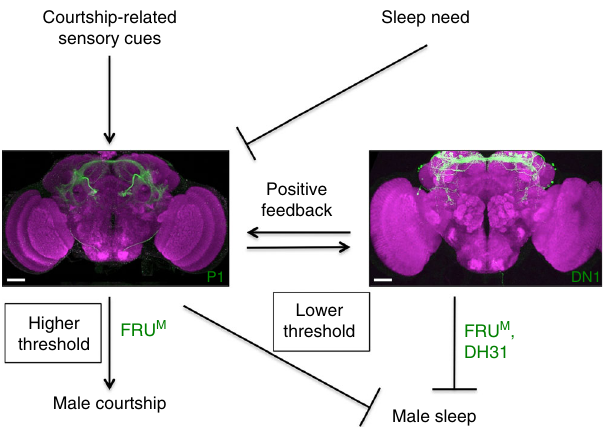
Fig. 10 Sex-speci fi c interaction between courtship and sleep. The male-speci fi c P1 neurons integrate external courtship-related sensory cues and internal sleep need, then inhibit male sleep, and promote male courtship in a threshold-dependent manner. P1 neurons form mutually excitatory connections with sleep-controlling DN1 neurons, which might be important for a persistent behavioral state. Furthermore, FRU M differentially regulates male courtship and sleep in P1 and DN1